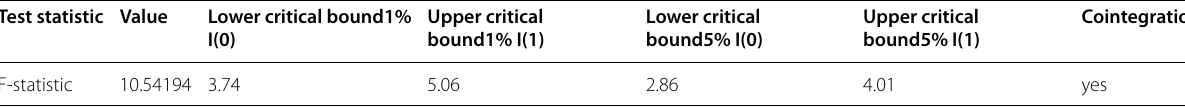
Table 5 ARDL bound